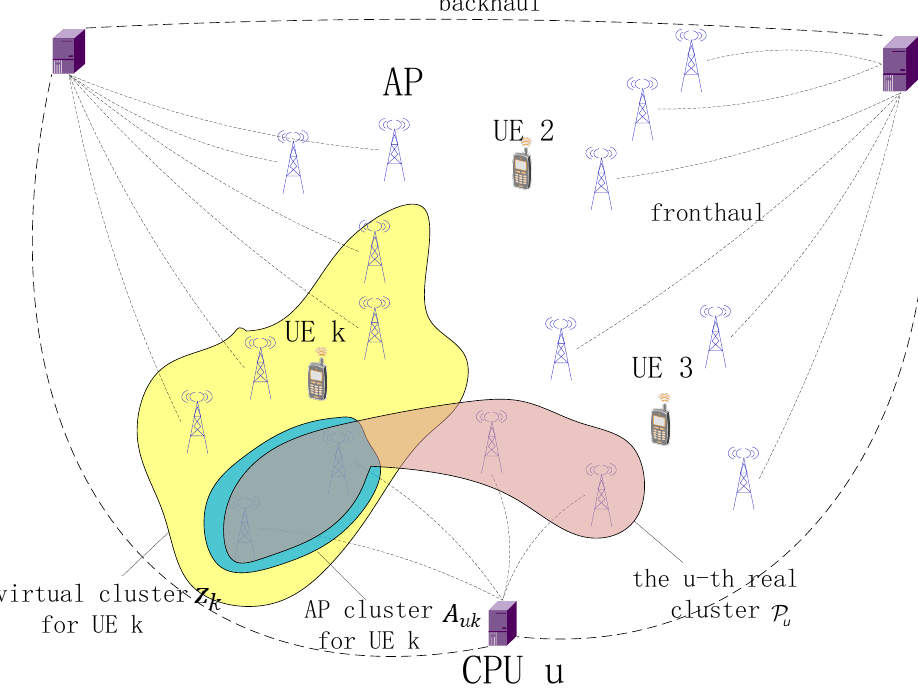
Figure 1. Example of virtual clusters in the CF-M-MIMO with multiple CPUs. The yellow area, red area and blue area represent virtual cluster, real cluster and the intersection of virtual cluster and real cluster,